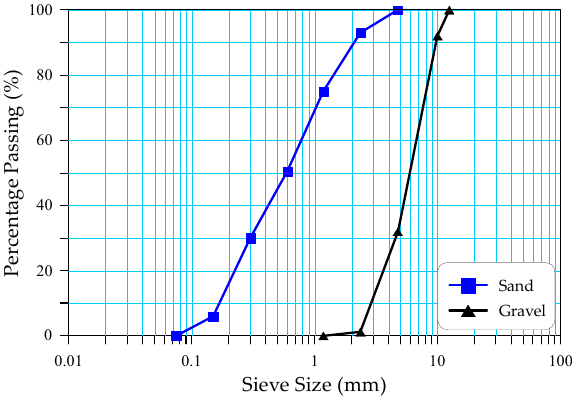
Figure 1. Particle grading of the used crushed gravel and sand.